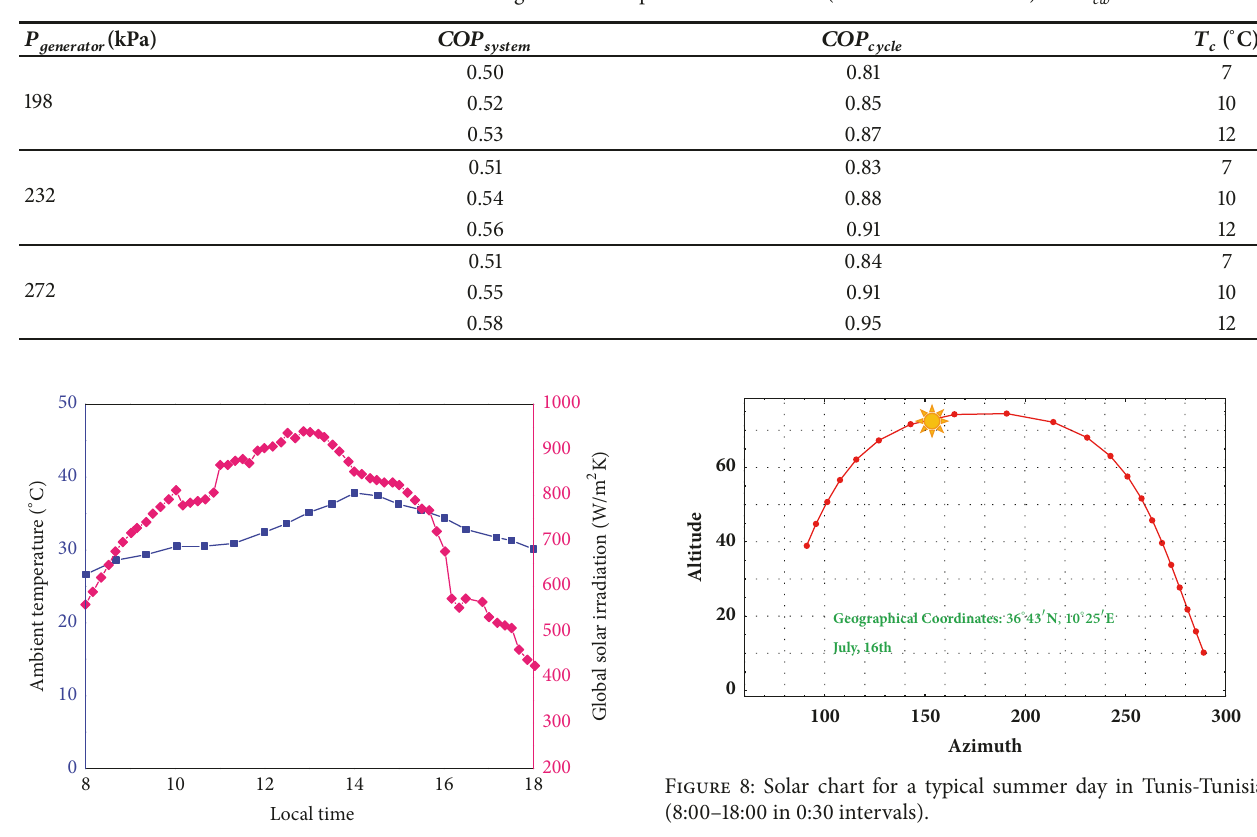
𝐶𝑂𝑃 𝑐𝑦𝑐𝑙𝑒 = 0.84, 0.91, 0.95 for chilled water tem- perature, respectively, set at 7 ∘ C, 10 ∘ C, 12 ∘ C, with corresponding values for 𝐶𝑂𝑃 𝑠𝑦𝑠𝑡𝑒𝑚 = 0.51, 0.55, 0.58.